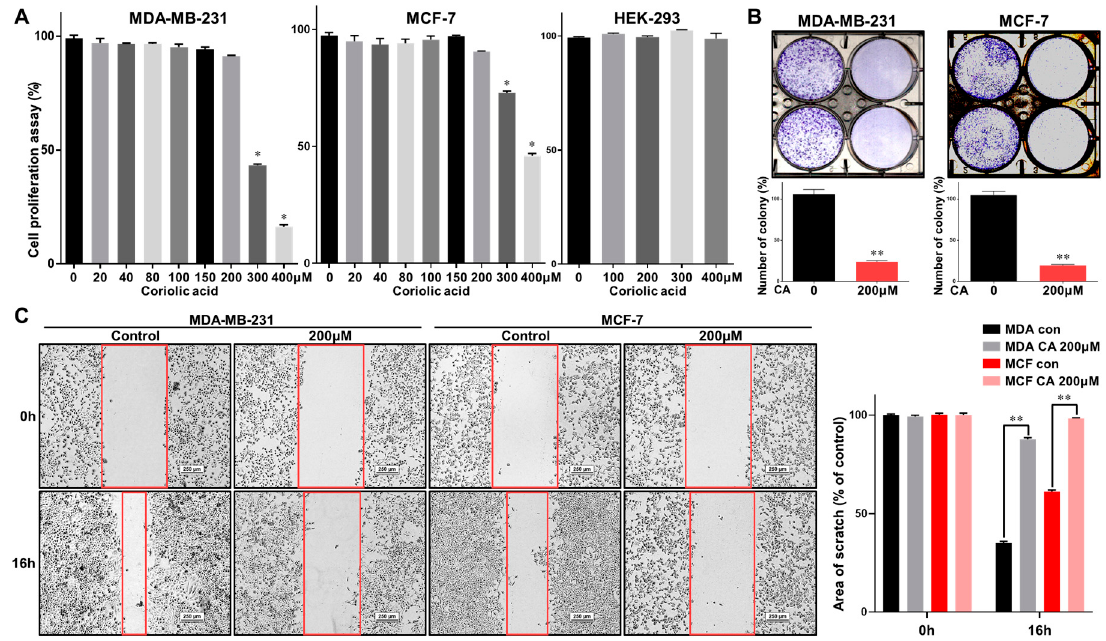
Figure 2. Molecular structure of coriolic acid, the cancer stem cell (CSC) inhibitor isolated from S. herbacea